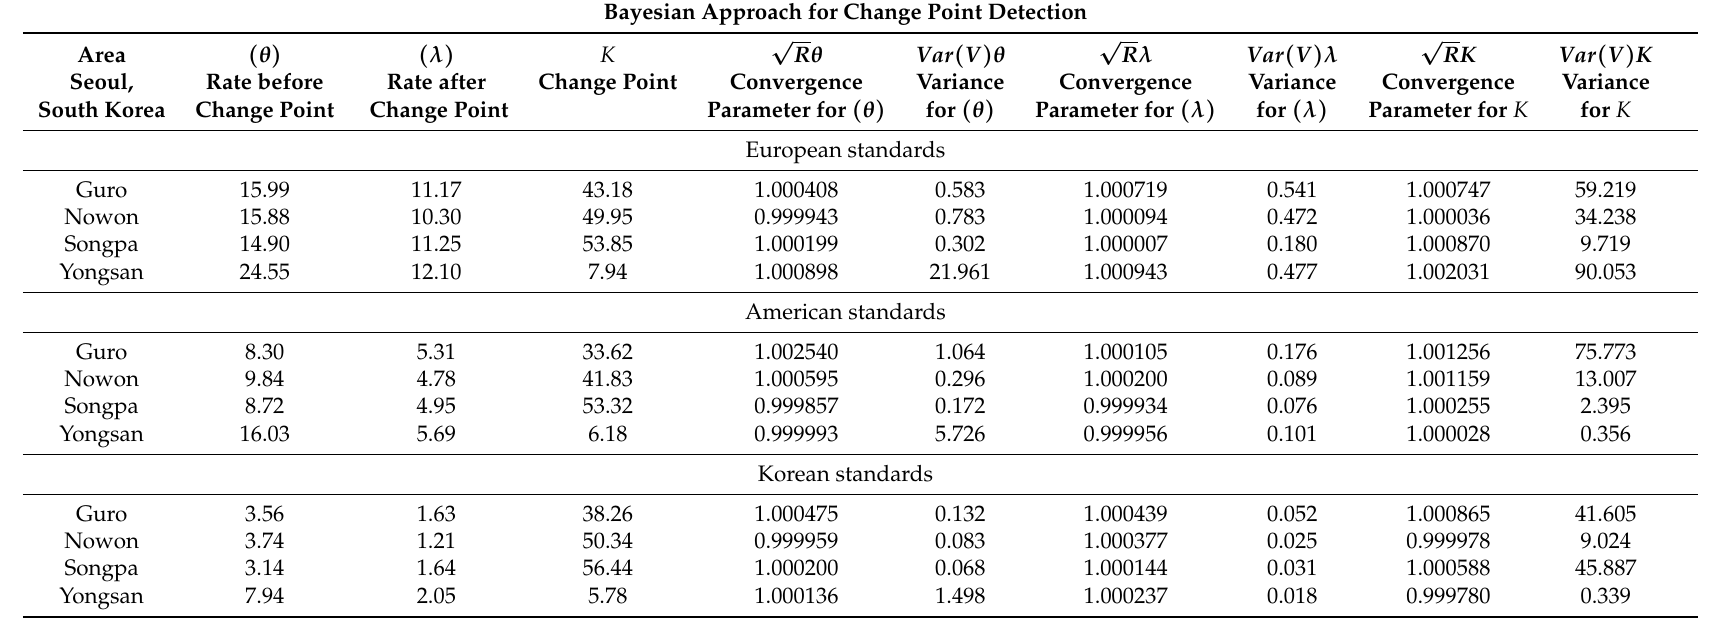
Table 11. PM 2.5 Change Point ( k ) for European, American and Korean Standards through Bayesian